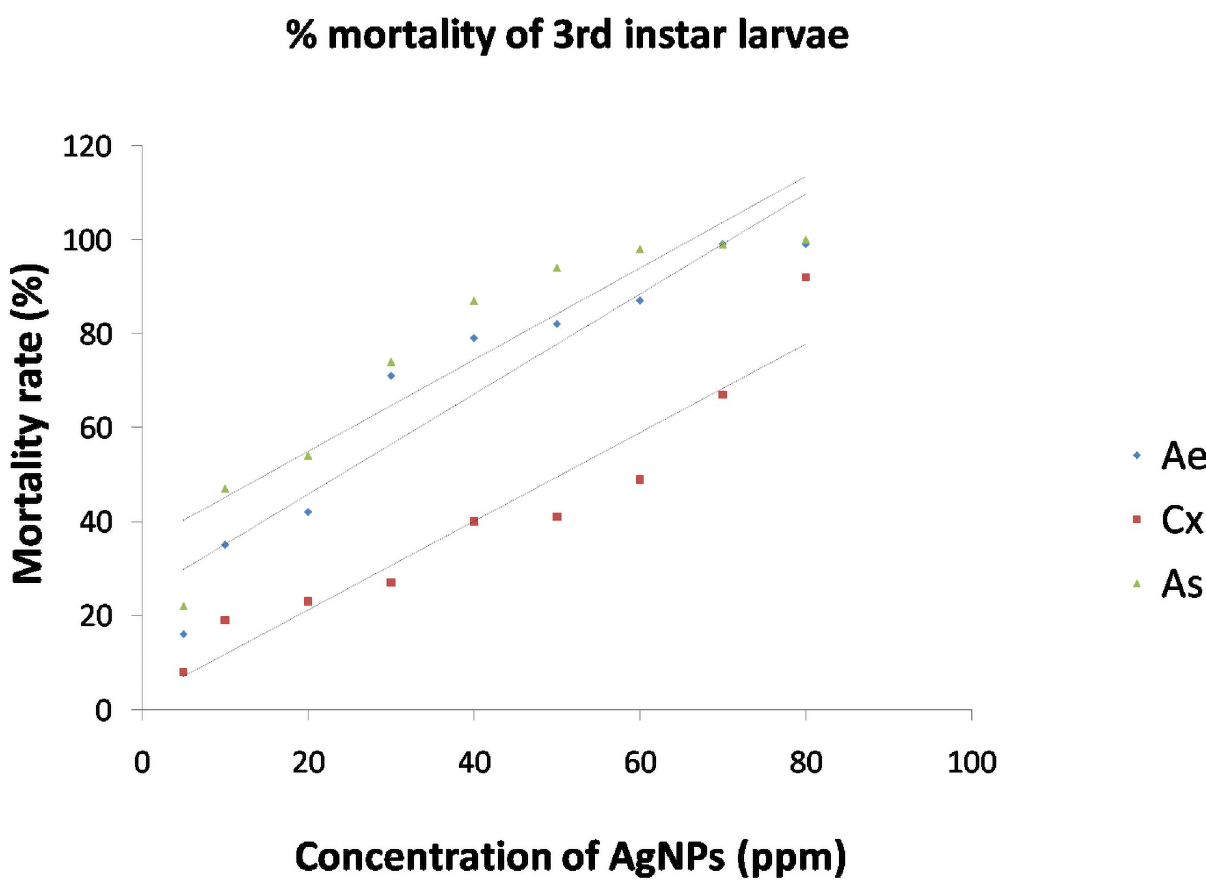
Fig 10. Mortality curves for ovicidal activity of AgNPs synthesized by Bacillus marisflavi against the eggs of Ae . aegypti , Cx . quinquefasciatus and An . Stephensi .